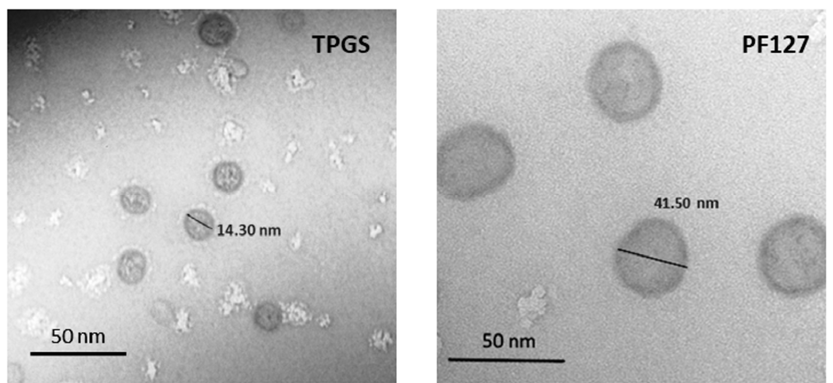
Figure 1. Morphometric characterization of TPGS and PF127 empty micelles: TEM images of TPGS and PF127 micelles showed spherical nanostructures of around 14 and 40 nm, respectively.